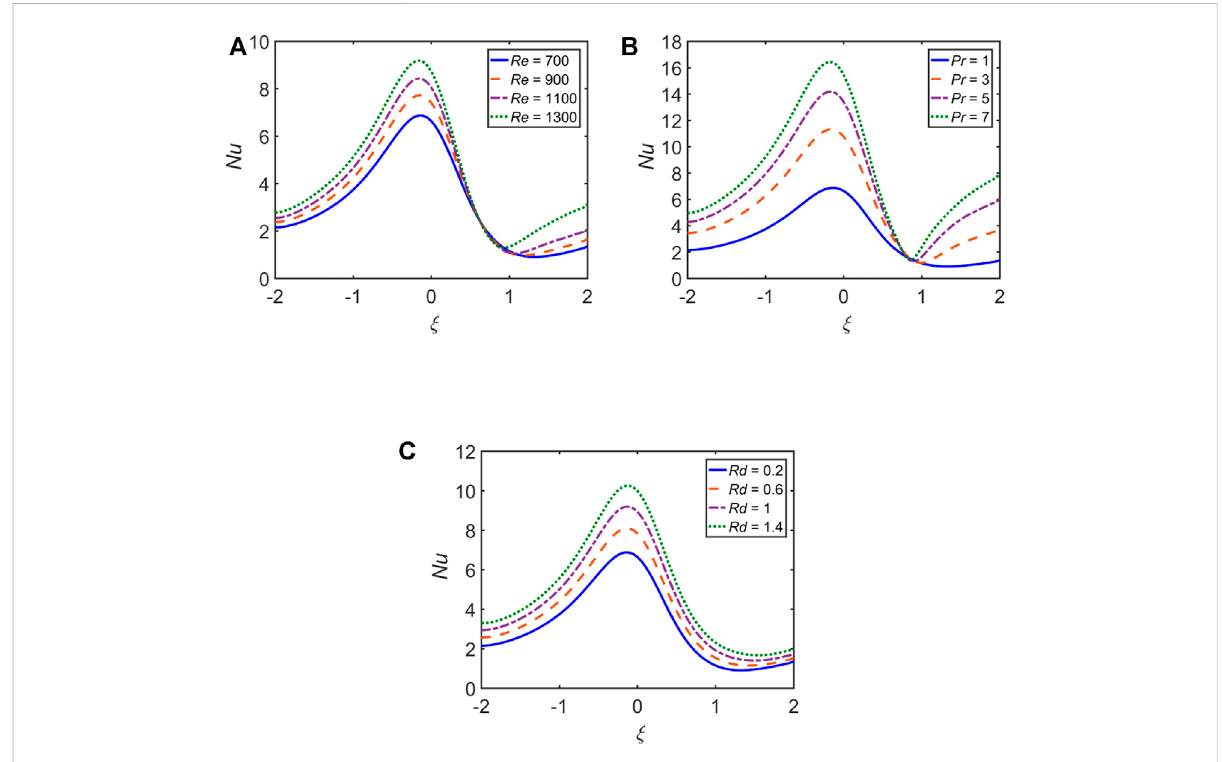
Impact of (A) Re , (B) Pr , and (C) Rd on Nu .